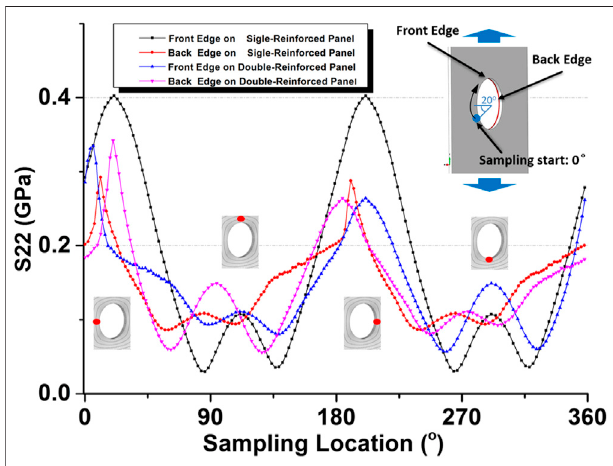
FIGURE 14 | S22 distribution on the edges of the hole of the SSR sample and DSR sample.